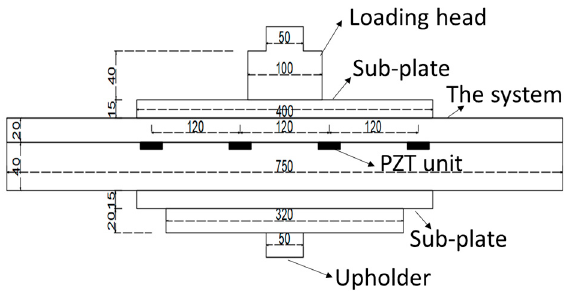
Figure 6. Schematic diagram of the loading structure.